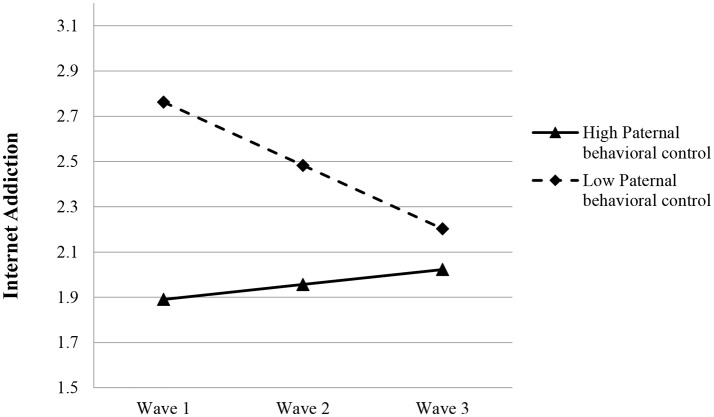
Growth trajectories of adolescent internet addiction as a function of paternal behavioral control. The figures were plotted based on Model 4a shown in Table 4. High level indicates 1SD higher than the mean value; low level indicates 1SD lower than the mean value.